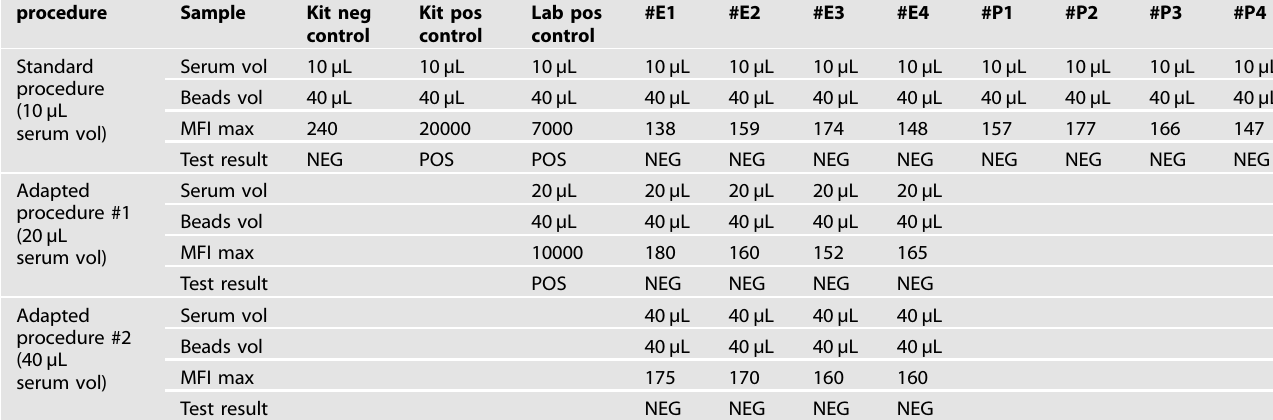
Table 1. Anti-HLA analysis in mice sera following injection of HuMSC-EV.